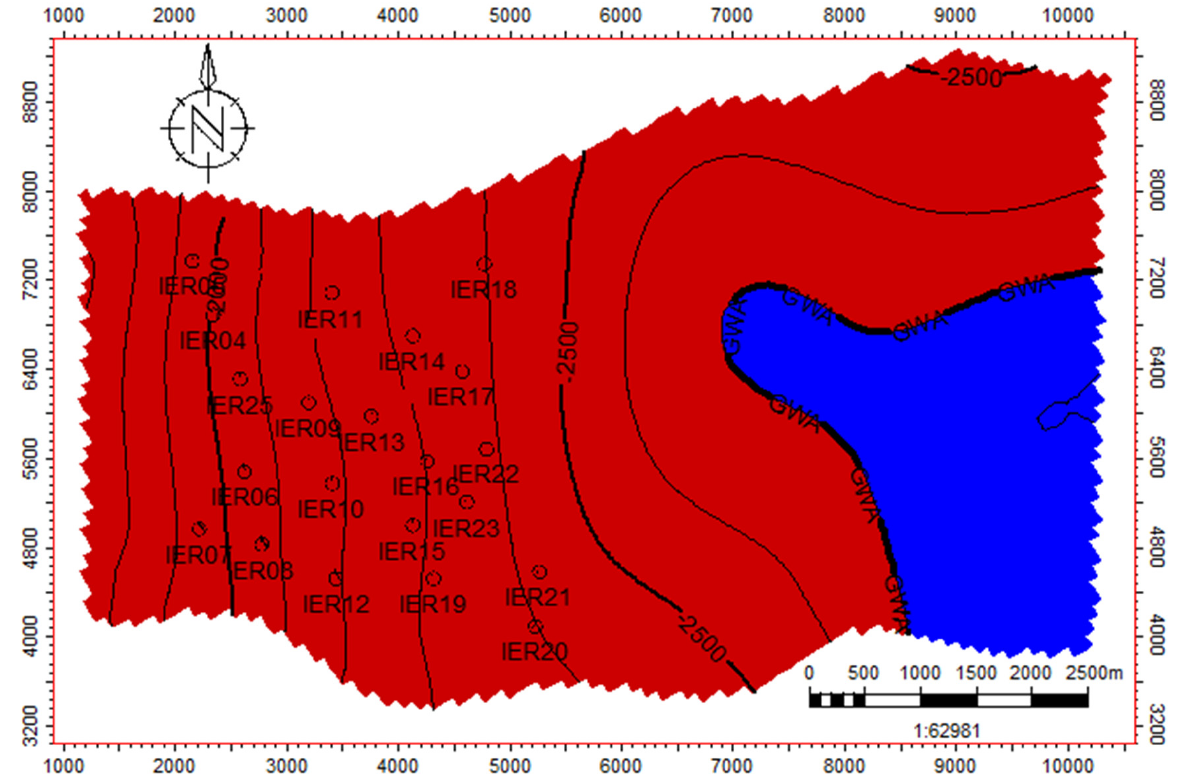
Figure 4. Mid reservoir surface map with wells and contact locations.